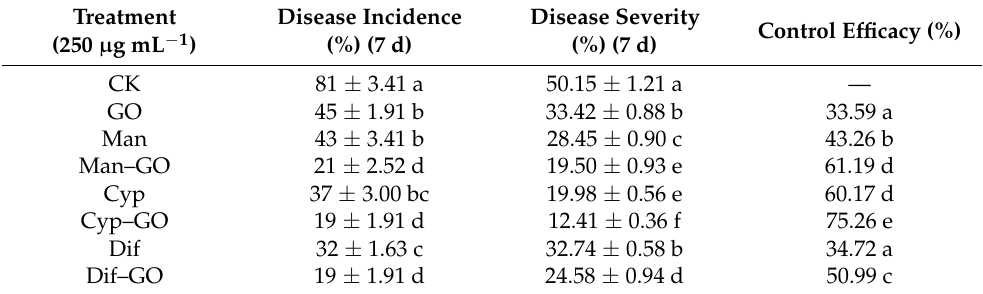
Table 3. Control efficiencies of GO, fungicides and GO–fungicides on F. graminearum in the